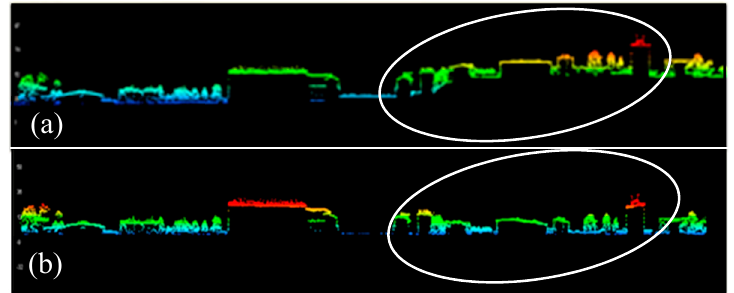
Figure 15. ( a , b ) Roof geometry changes during normalised digital surface model (NDSM) extraction from airborne lidar data.